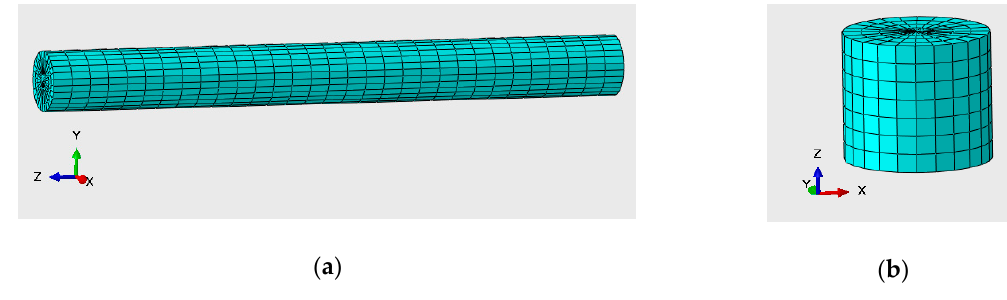
Figure 8. ( a ) Horizontal strain sensor; ( b ) Vertical strain sensor.